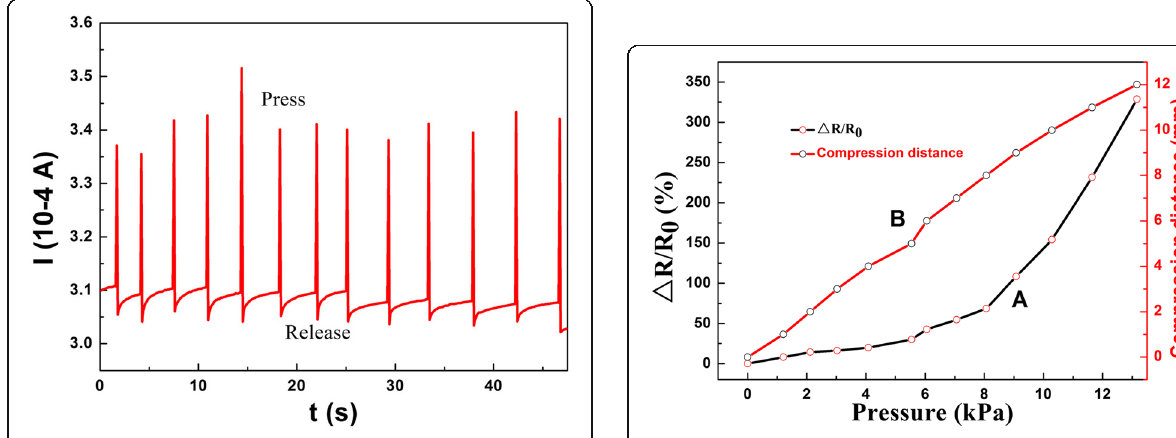
Fig. 5 Cyclic pressure-removed response of the PANI/sponge with about 2-mm compressive deformation forced by finger